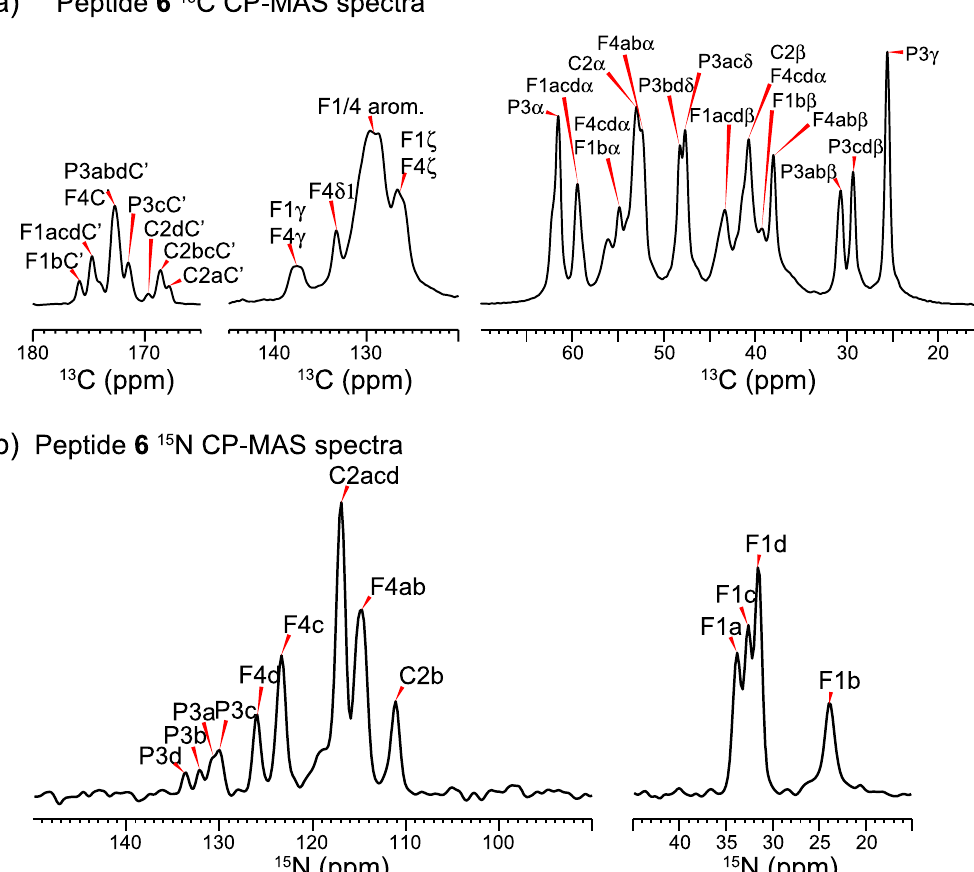
Figure 3. 13 C ( a ) and 15 N ( b ) cross-polarization magic-angle spinning (CP-MAS) spectra of the PFA-tagged π -clamp peptide 6 show four sets (denoted as ( a , b , c , d ) after the residue number) of well resolved peaks, indicating conformational